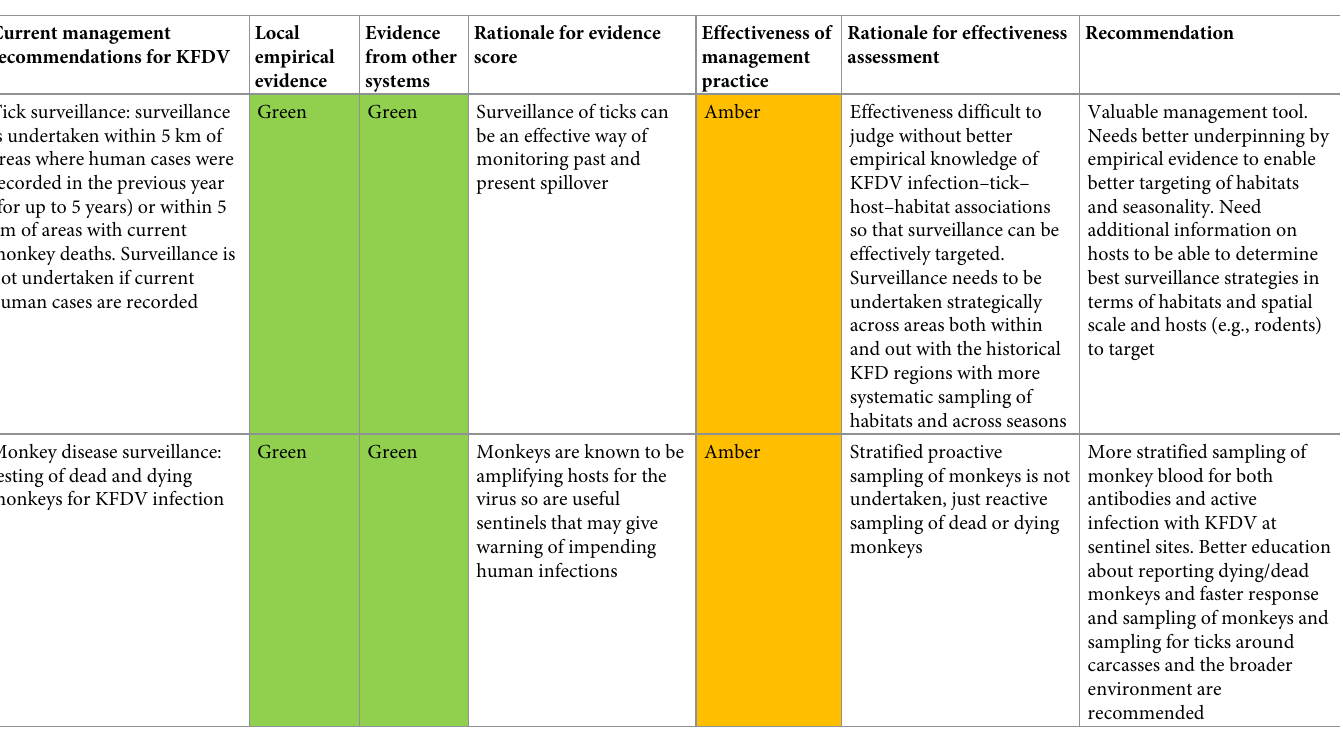
Fig 1 indicates how current management recommendations for KFD in India align with the hierarchical barriers to human spillover identified in our extended framework for vector- borne diseases. From this, it is clear that current recommendations are conventional interven- tions largely focused on humans as the spillover host: (i) reducing exposure through commu- nity education and tick bite prevention; and (ii) reducing the number and severity of cases in humans through vaccination. Measures for reducing tick populations at perceived infection hotspots and monitoring disease events in monkeys as a sentinel vertebrate host are also encompassed in existing government KFD management recommendations. Finally, the experiences and views of disease managers in implementing and engaging with local communities on specific current recommended management practices are summarised in Table B in S1